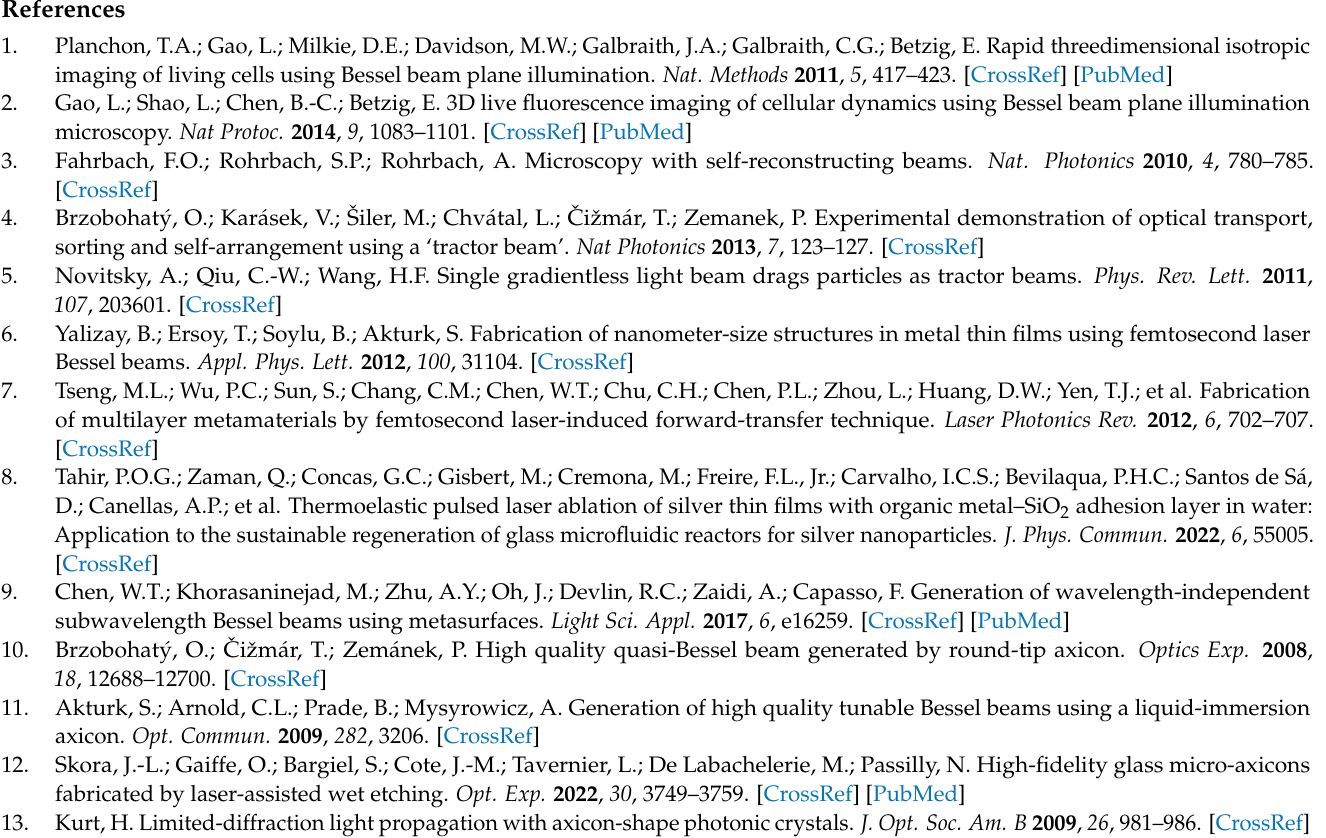
Figure S1: Raman spectra of transferred single layer grapheme. Figure S2: The focusing performances of a PDMS/SLG device coupled to a GRIN lens with 0.9 mm focal